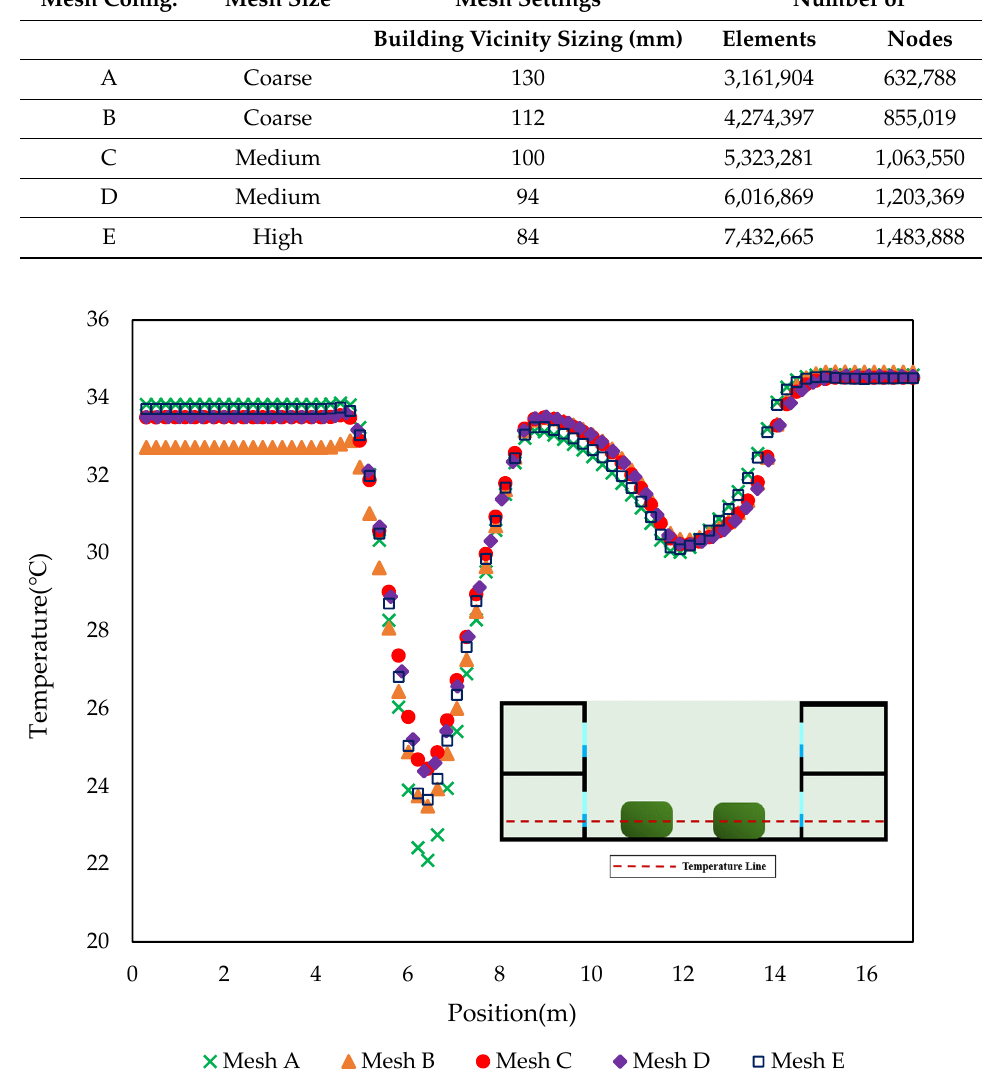
Table 2. Mesh setup for sensitivity analysis (courtyard with small trees). Mesh Config.